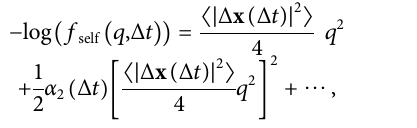
Frontiers in Physics |